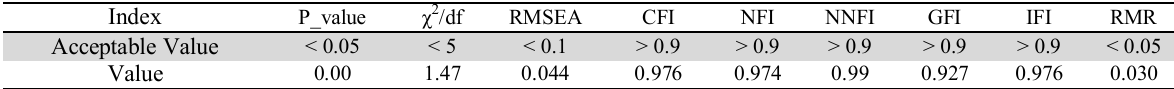
Fit indexes of model